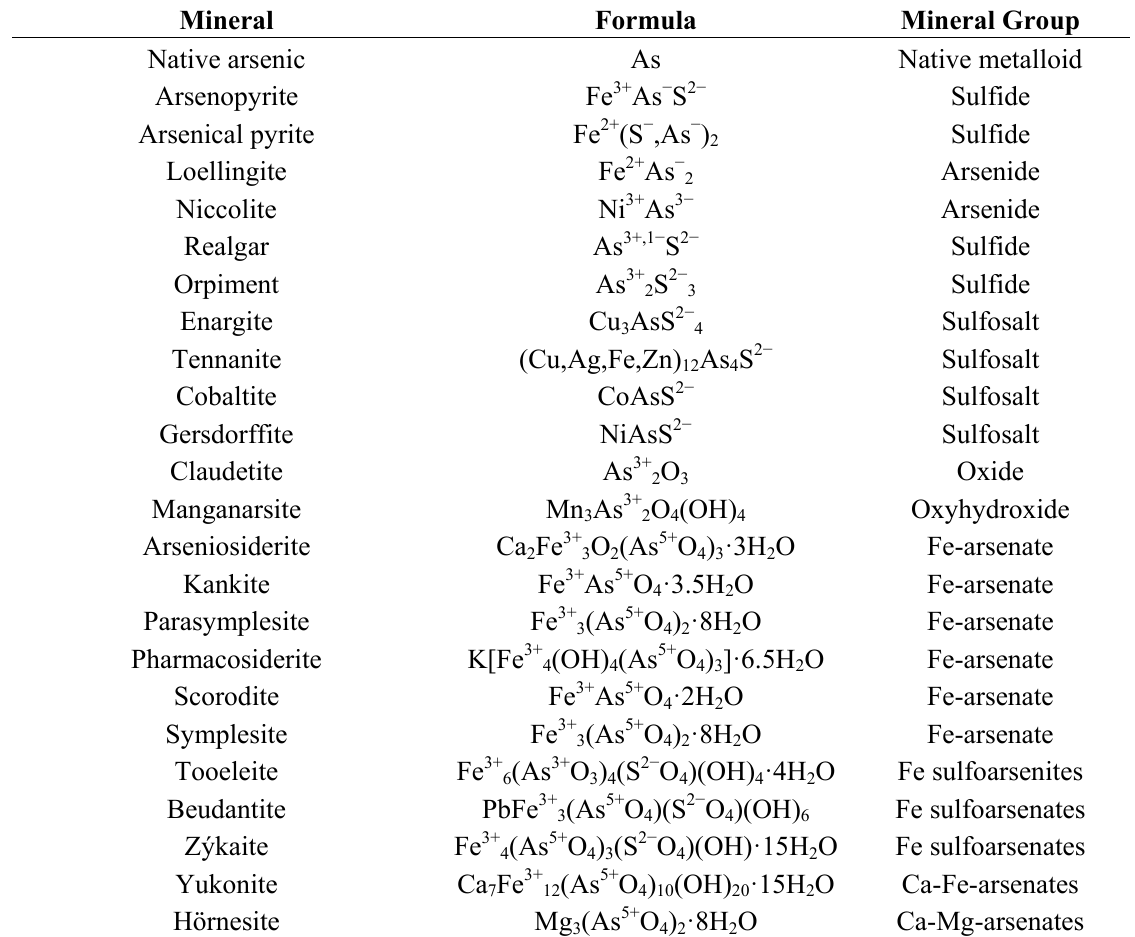
Table 1. Examples of As-bearing minerals in mining-affected environments. Where known, speciation is shown for redox-sensitive